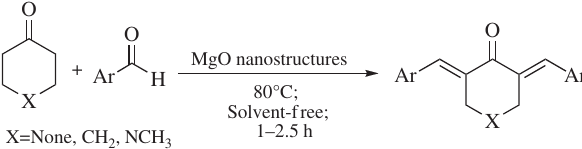
Scheme 1: Synthesis of α , α′ -bis (substituted-benzylidene) cyclo- alkanone derivatives over MgO grit like